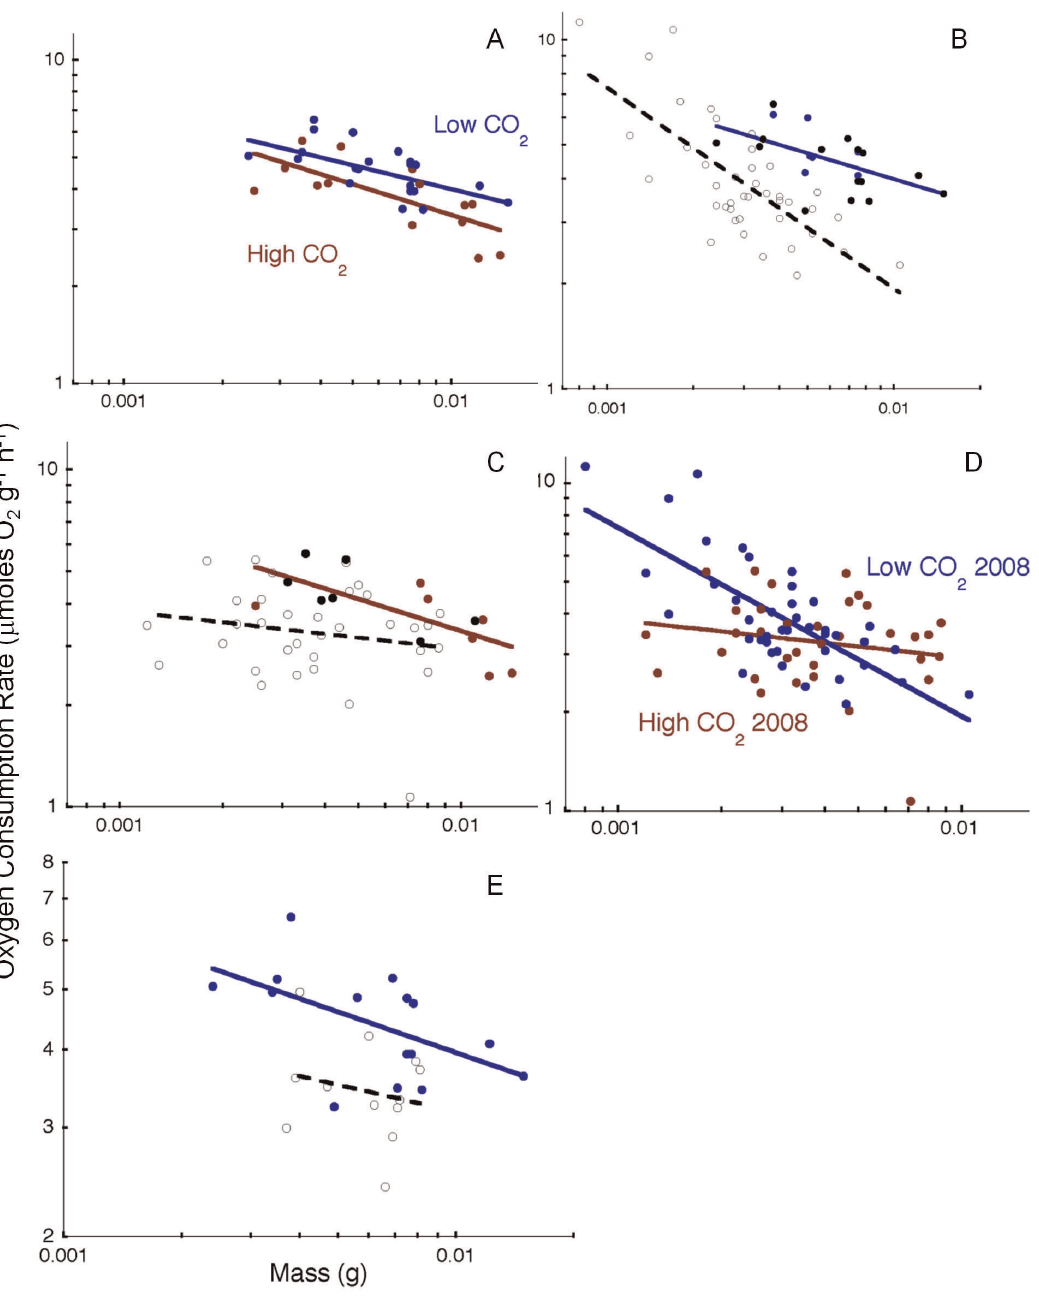
Figure 1. Oxygen consumption rates (MO 2 , m moles O 2 g 2 1 h 2 1 ) of the pteropod, Limacinahelicinaformaantarctica as a function of body mass (M). A) In 2007, MO 2 was significantly higher at low (380 + 180 m atm, blue; MO 2 = 1.29 M 2 0.25 ) than at high (789 + 1000 m atm, red; MO 2 = 0.78 M 2 0.32 ) CO 2 partial pressure (PCO 2 ). The individual CO 2 treatment levels are separated in subsequent panels. MO 2 was significantly higher in 2007 (closed circles) compared to 2008 at both low (panel B; open circles; MO 2 = 0.14 M 2 0.58 ; closed circles180, blue and 380, black, equation above) and high (panel C; open circles, MO 2 = 1.73 M 2 0.12 ; closed circles 790, red and 1000, black, equation above) CO 2 partial pressures. D) In 2008, carbon dioxide (1000 ppm, red, equation above) had no effect on MO 2 relative to control levels (380 ppm, blue, equation above). E) Food deprivation in